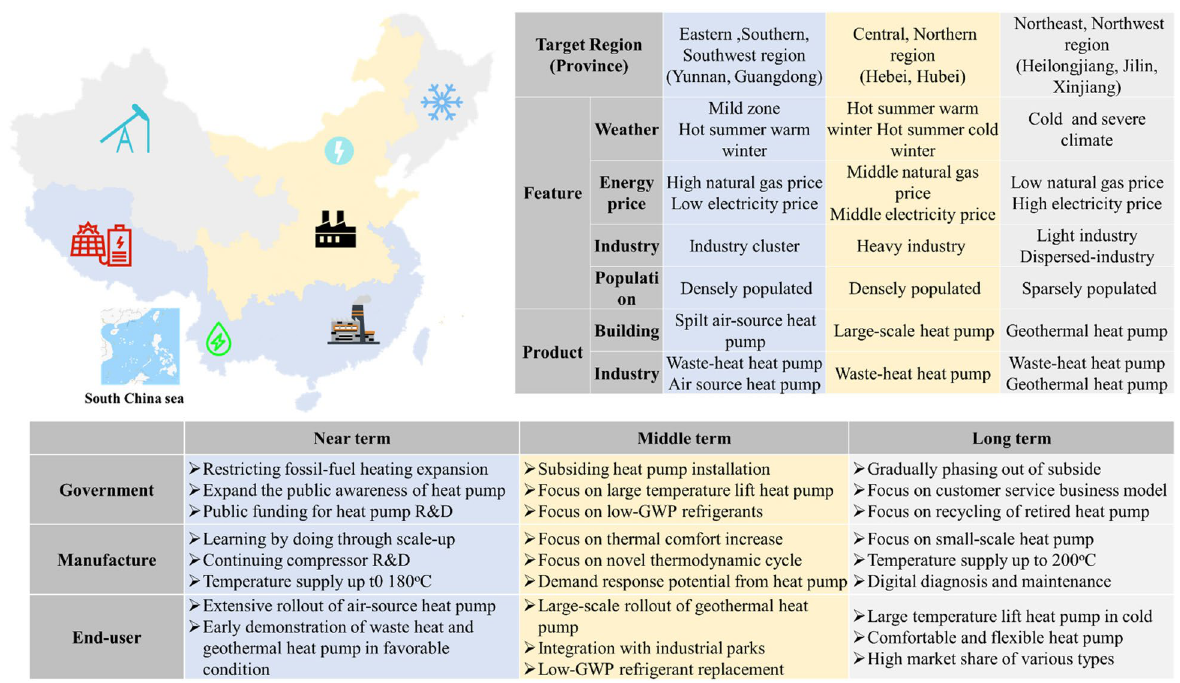
Fig. 12 Technology roadmap for heat pump development in China 2060 carbon-neutrality. Shown in the box is a proposed technology roadmap for heat pump decarbonization. Government, Manufacturer, and users could work together to create a development roadmap for heat pump market penetration in near-term, middle-term, and